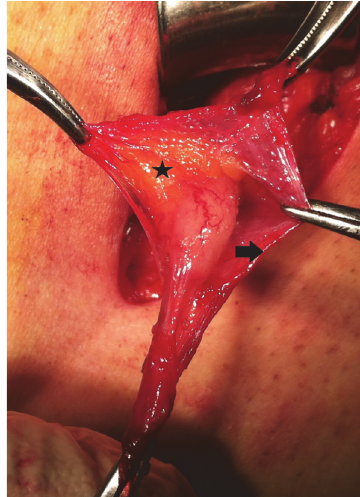
Figure1:Normalappearingthevermiformappendixintheinguinal hernia sac. Fibrous connections (star) between the vermiform appendix and surrounding hernia sac (arrow).